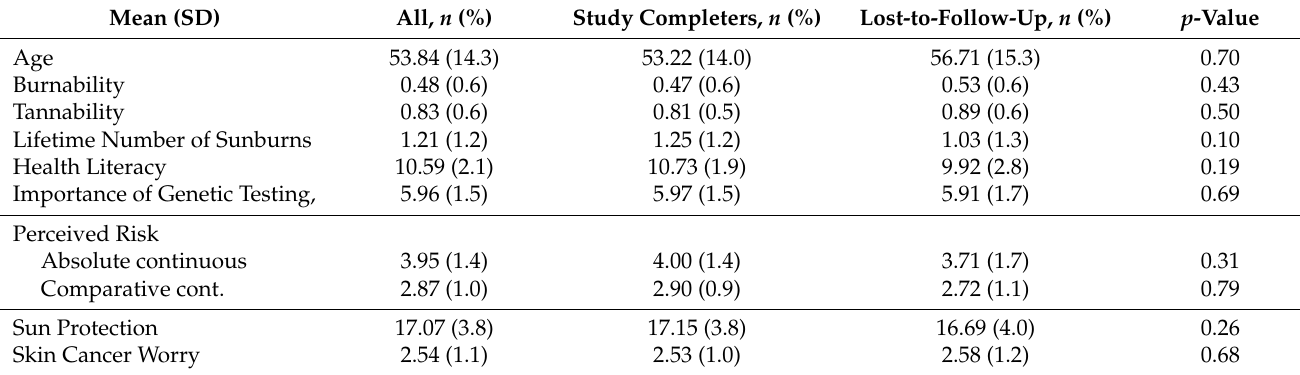
Table 2. Patient continuous baseline characteristics by follow-up status (N =